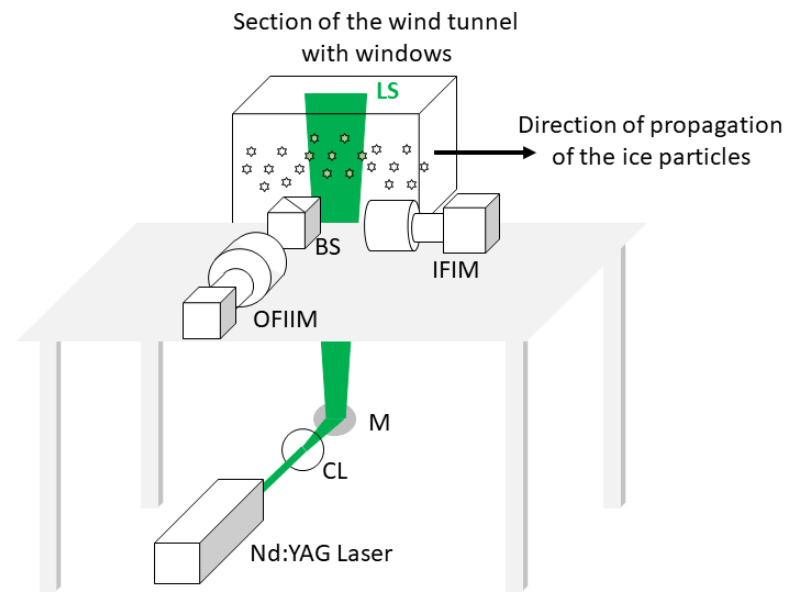
Figure 2. Experimental setup (LS: laser sheet; BS: beam splitter; M: mirror; CL: cylindrical lens IFIM: in-focus imaging; OFIIM: out-of-focus interferometric imaging). in-focus imaging; OFIIM: out-of-focus interferometric